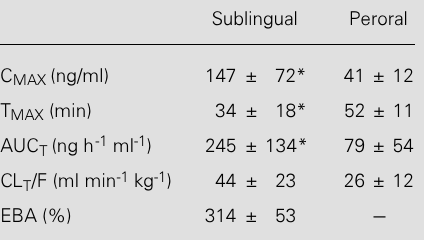
Table 2 - Pharmacokinetic parameters after pro- pranolol administration to ambulatory patients with severe essential arterial